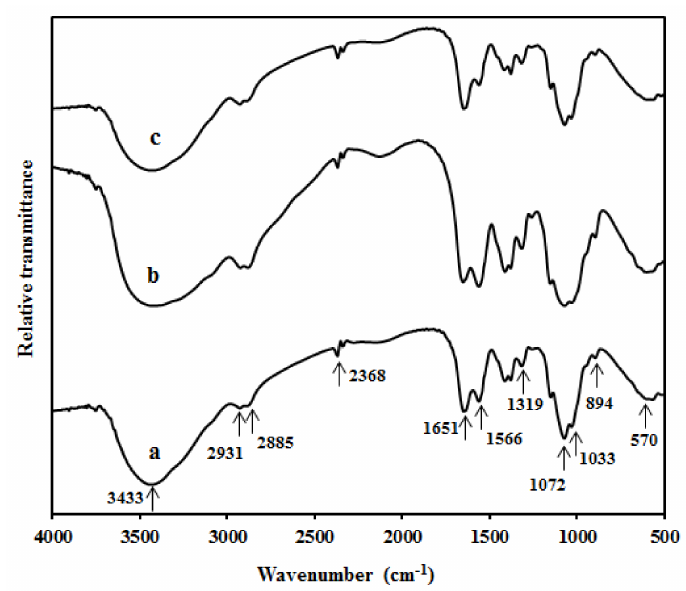
Figure 2. Fourier transform infrared (FT-IR) spectra of ( a ) chitosan, ( b ) bio-composite film with 4 wt% cellulose nanocrystal (CNC), and ( c ) bio-composite film with 4 wt% CNC and 20 wt%